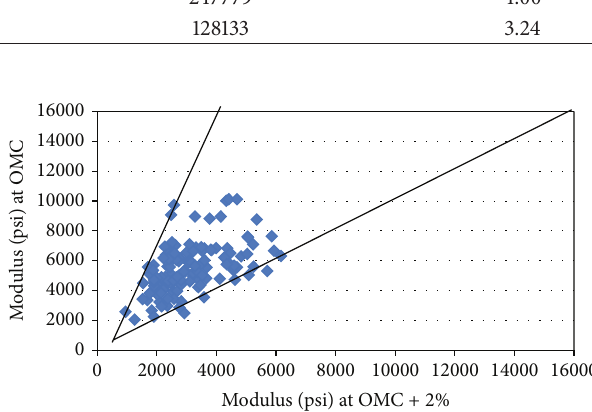
Figure 7: Modulus variation and moisture content of soil ( 𝜎 𝑐 = 2psi and 𝜎 𝑑 =